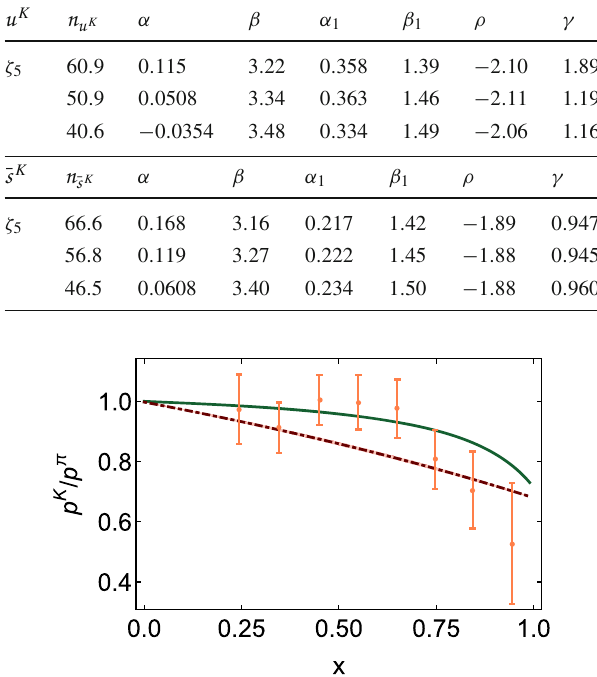
Table 6 Coefficients and powers that provide interpolations for the computed kaon valence-quark distribution functions, depicted in Fig.13, when used in Eq.(33): Rows 1–3 – u -quark, unchanged from Table 5, included here to simplify comparisons; and Rows 4–6 – ¯ s - quark, obtained using mass-dependent splitting functions, Eq.(59)